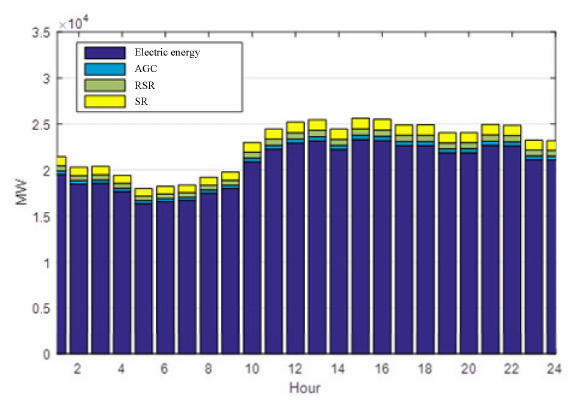
Figure 4. Unit commitment in non-summer.